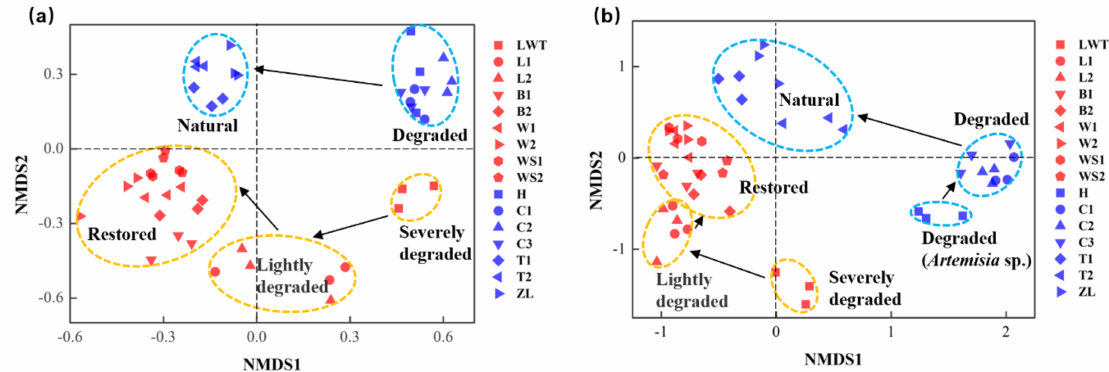
Figure 7. NMDS analysis of the soil bacterial ( a ) and fungal ( b ) community in the Phragmites and the Carex marsh sampling sites. The red and blue symbols represent the Phragmites and Carex sites in the NMDS analysis, respectively, and the black arrows indicate the bacterial or fungal composition shift in the different wetland sites.